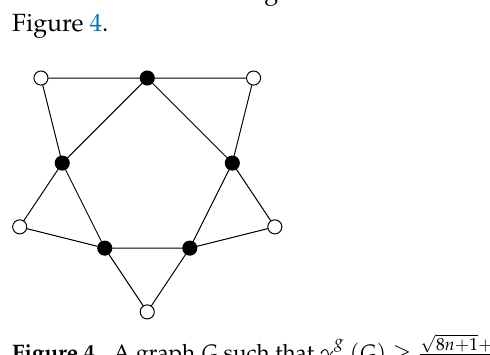
Figure 4. A graph G such that γ g